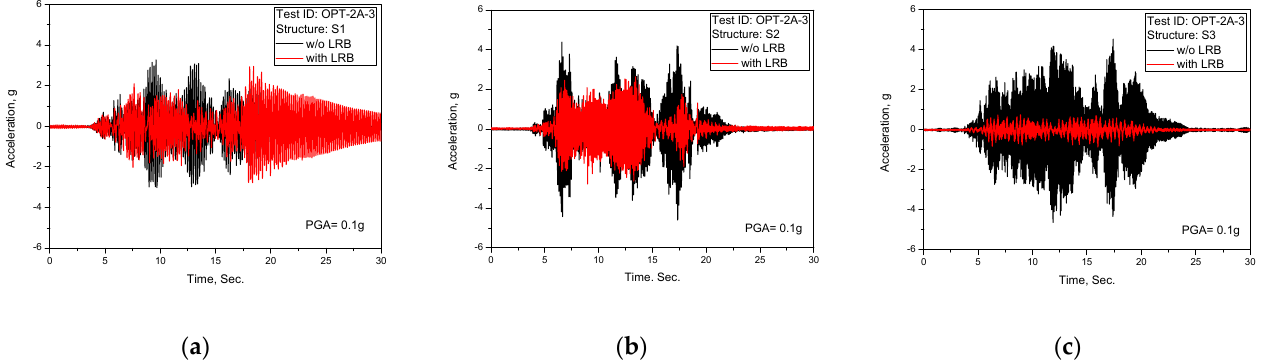
Figure 8. Test results of acceleration time history response (TEST ID: OPT-2A-3, PGA = 0.1 g): ( a ) S1; ( b ) S2; ( c ) S3.